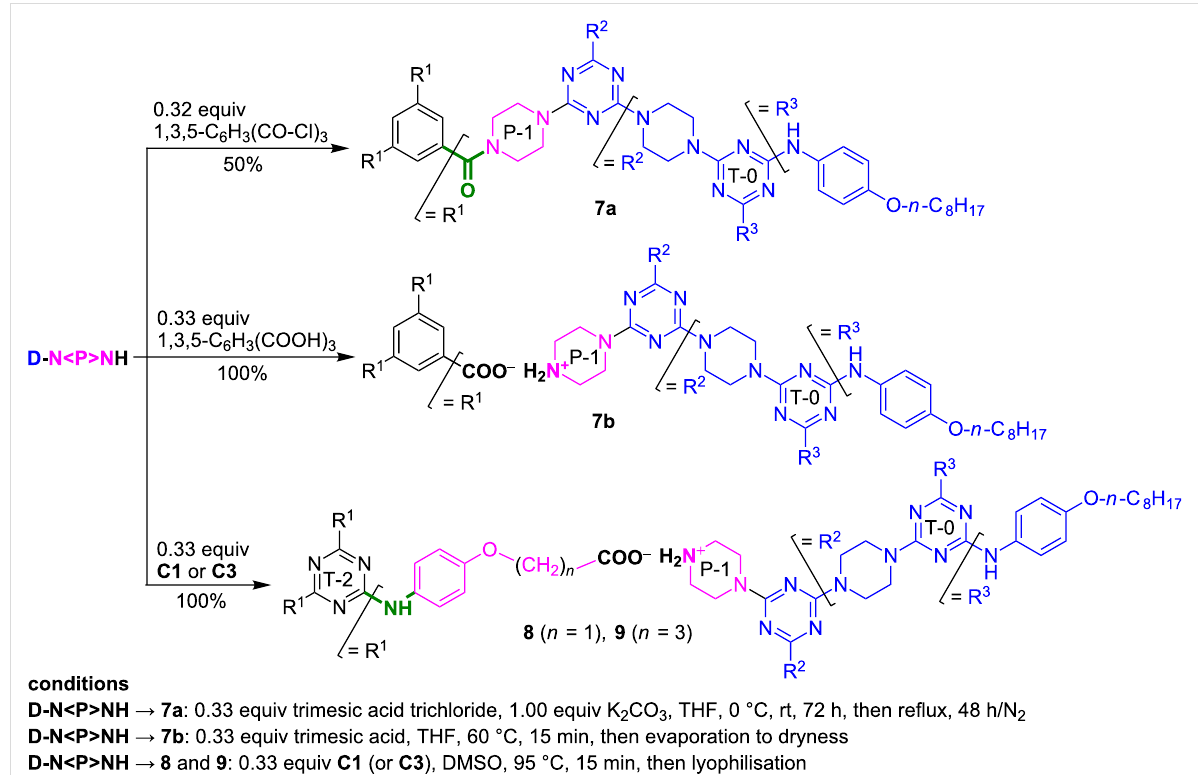
As in the case of other amino- s -triazines [30-33,36,45,46], for G-0 dendrons 2a and 3 , a topologically idealised model pre- dicted a three terms ( syn–syn anti–syn anti–anti ) rota- tional equilibrium about the C( s -triazine)–N(exocyclic) (Figure 2) partial double bonds, at room temperature. Similar to simpler 4-hydroxyphenyl-based amino- s -triazine analogues of 2a and 3 [35,36], the optimised ( a–a ) geometry was found to be